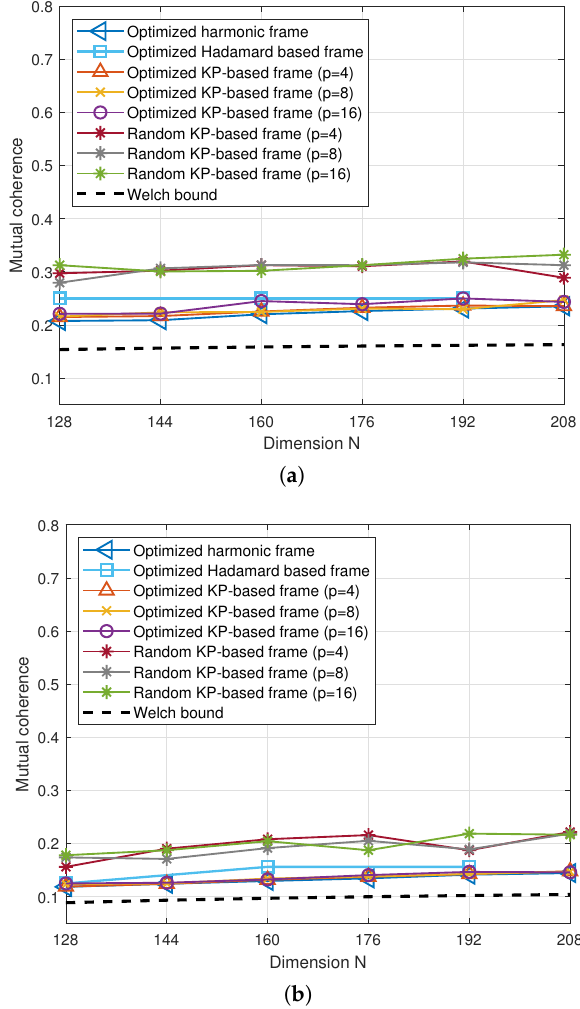
Figure 3. The mutual coherence of various frames over frame dimension N . ( a ) m = 32, ( b ) m = 64. In simulations, the CS measurement matrix A is from the optimized harmonic, op- timized Hadamard-based, random Kronecker-product-based, and optimized Kronecker- product-based frames, respectively, where N = 256 and m = 64. For random Kronecker- product-based and optimized Kronecker-product-based frames, we set q = 16. In Figure 4, we show the sparse recovery performance for the four frames in CS. If the sparsity s is small, e.g., s 19, the optimized harmonic, optimized, and random Kronecker-product- ≤ based frames show almost the same performances of success rate and MSE,